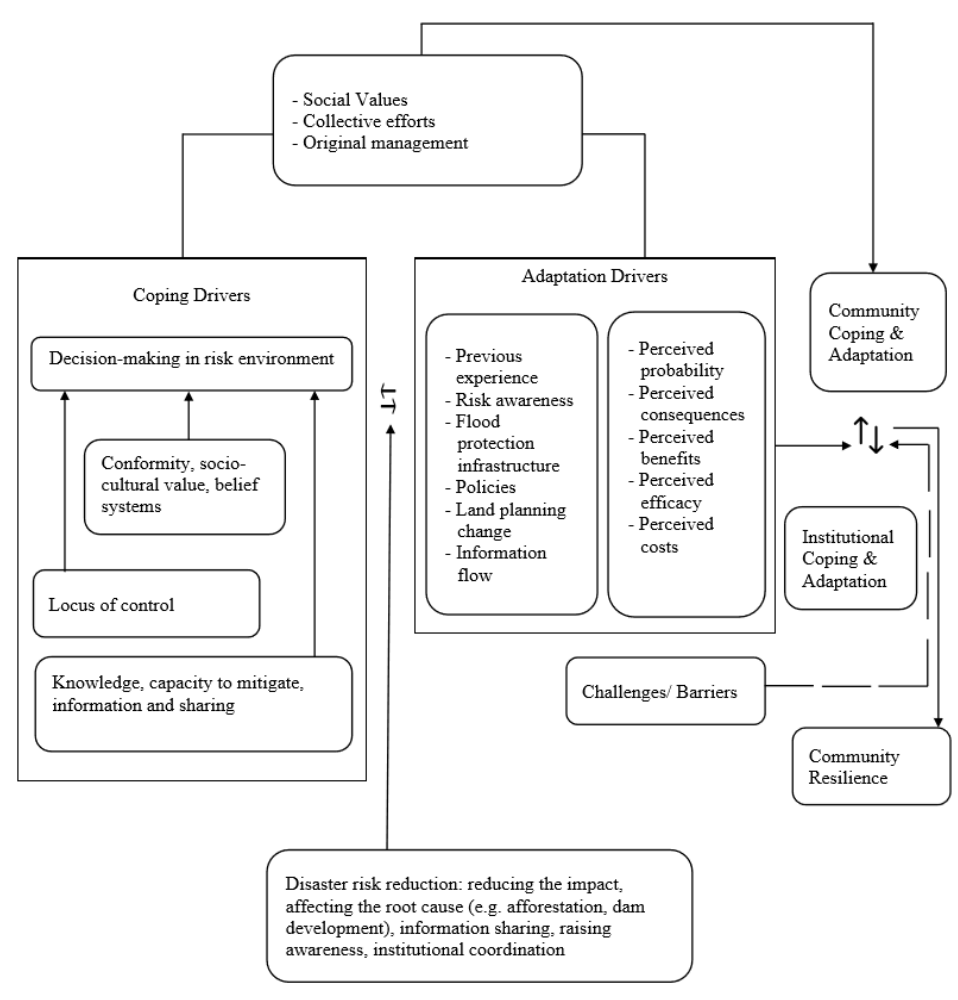
Figure 1. A conceptual framework explaining the interconnectedness between drivers of coping and adaptation to disasters at the local level.